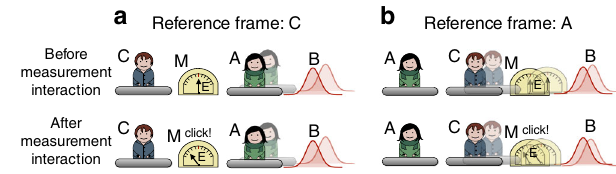
Fig. 9 Measurement in quantum reference frames. The measurement procedure as seen from the point of view of C, in a , and of A, in b . In a , C prepares an ancillary system, constituted by the position degrees of freedom of the apparatus M and a pointer E. The ancilla interacts with the quantum systems A and B. Subsequently, a projective measurement of the state of the pointer gives the outcome. In b , A describes the initial state as an entangled state of B, C, and M. The pointer E then interacts with both systems B and C. Finally, system E is measured. The measurement probability is the same as in the reference frame